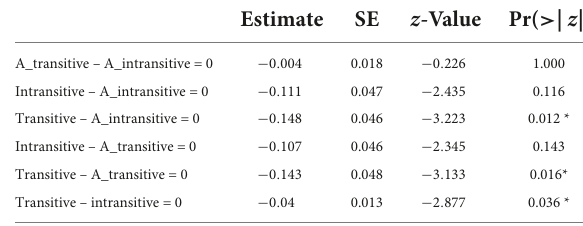
TABLE 7 Pairwise comparison of response